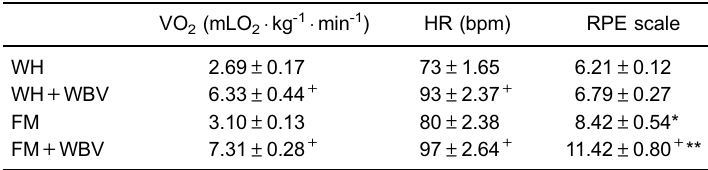
Table 2. Oxygen consumption (VO 2 ) and heart rate (HR) in HW (n=19) and FM (n=19) groups before and during stimulus of WBV.